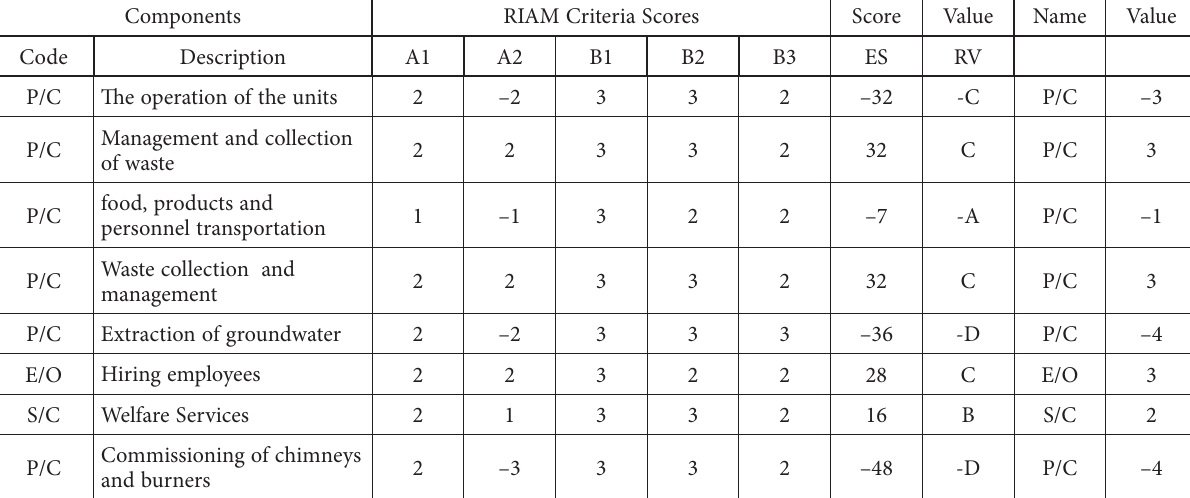
Table 9. Pastakia matrix in operational